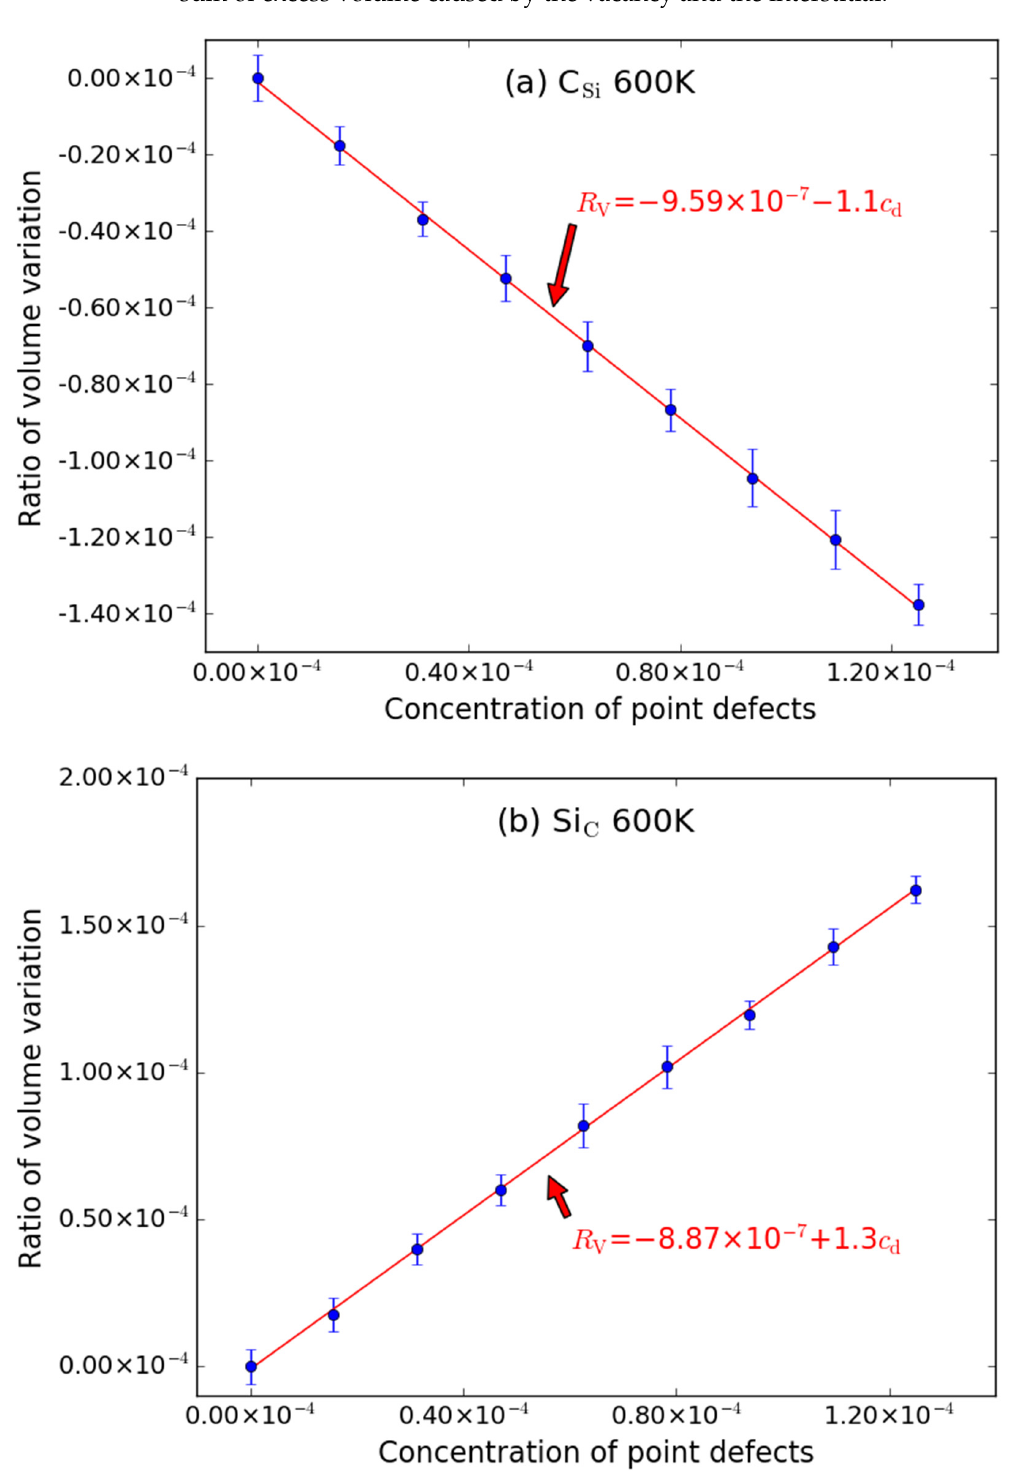
Figure 4. The ratio volume variation ( R V ) of the supercell caused by anti-site point defects (( a ) C Si and ( b ) Si C ) as function of concentrations ( c d ) of point defects at 600 K. The error bars denote the standard deviations of the values. The size of supercell in MD simulation is 20 a × 20 a × 20 a . The fitted R V ~ c d relationship for C Si and Si C are described by the following expressions: